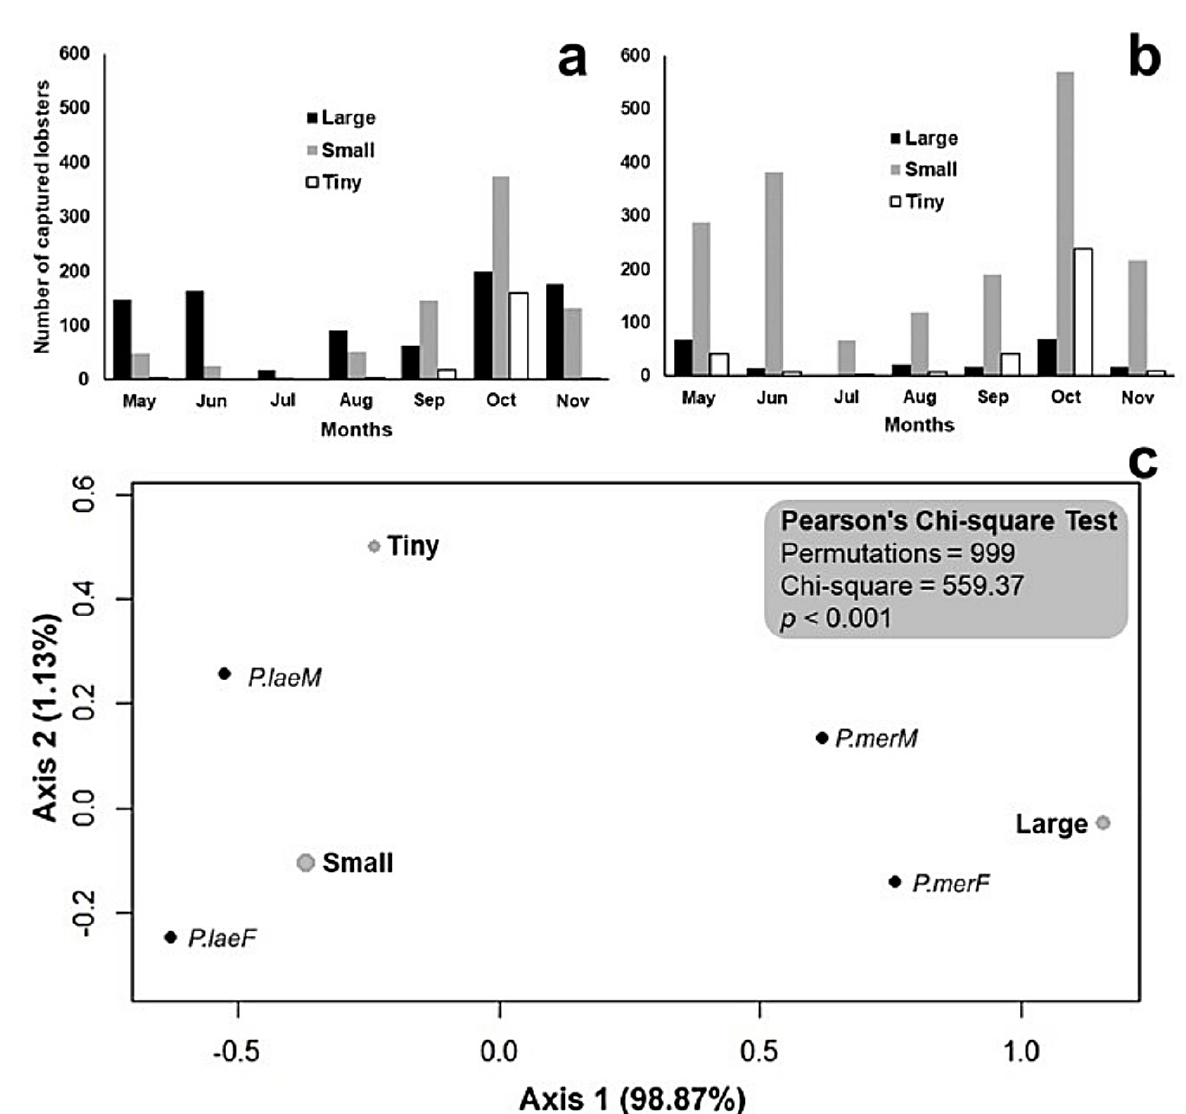
Figure 6. Artisanal fisheries of spiny lobster Panulirus spp. on eastern coast of Rio Grande do Norte by comercial sales categories. (a) Number of lobsters landed in commercial sales categories for P. meripurpuratus ; (b) Number of lobsters landed in commercial sales categories for P. laevicauda ; (c) Biplot of the correspondence analysis between the capture information according to the commercial sales categories vs. intersexual classification (P.mer – P. meripurpuratus , P.lae - P. laevicauda , M - male, F -